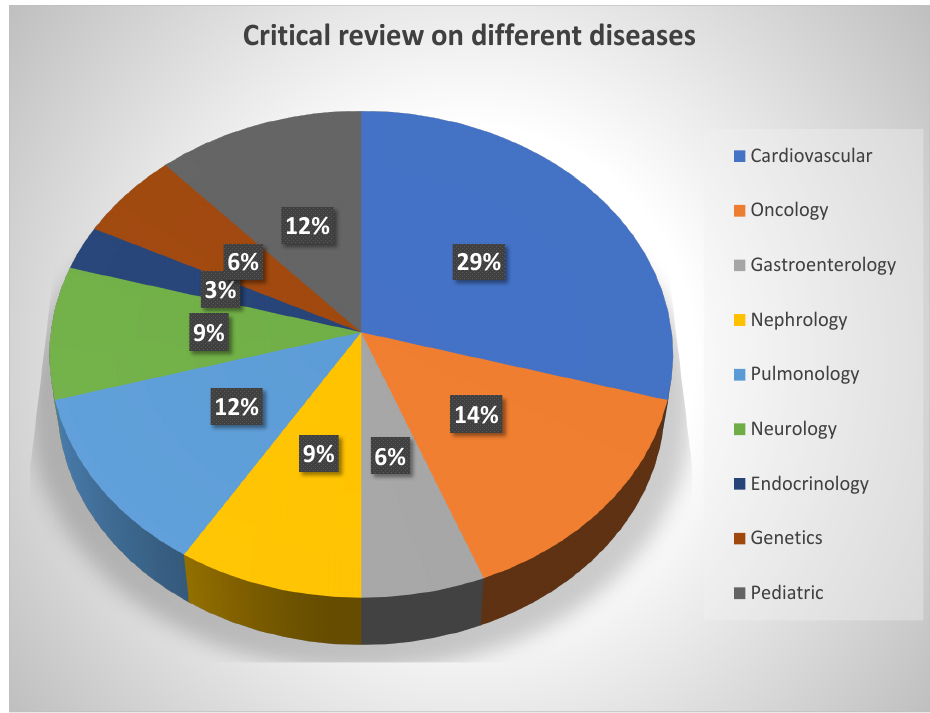
Figure 7. Critical review on different